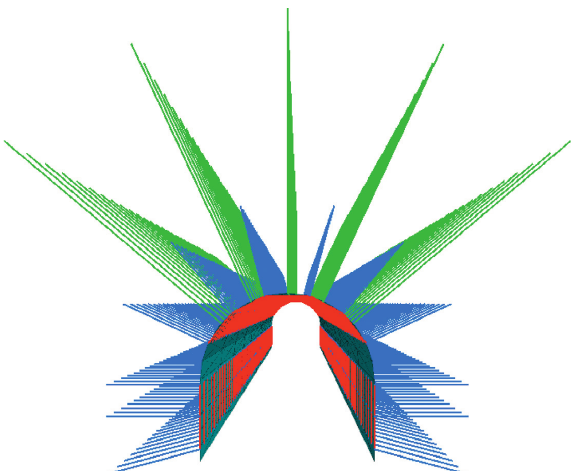
Figure 2: Original support